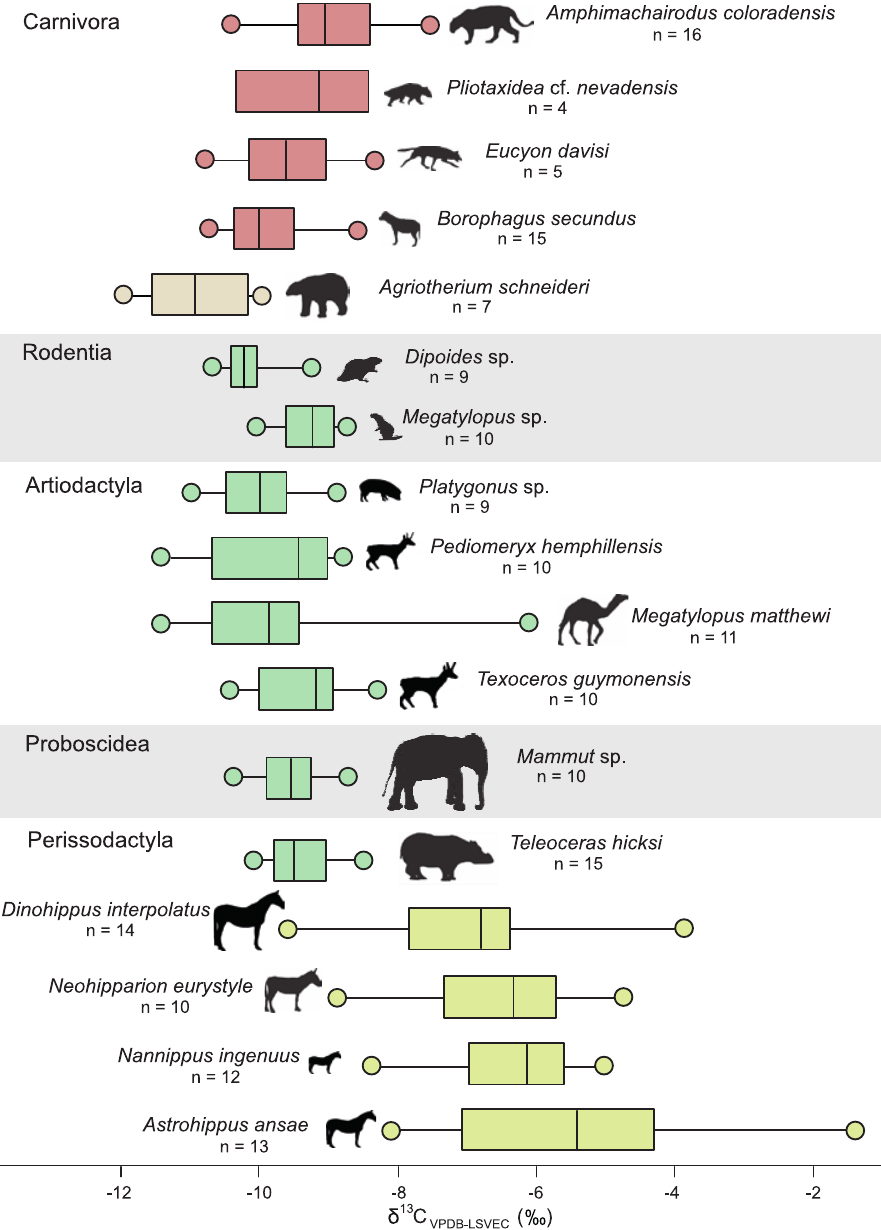
Fig. 1. δ 13 C values for Optima Local Fauna mammals (Miocene, late Hemphillian, Oklahoma, USA). Color differences between Agriotherium schneideri and other carnivorans (red vs. buff) and among herbivores (green vs. yellow) indicate the major statistical differences within these